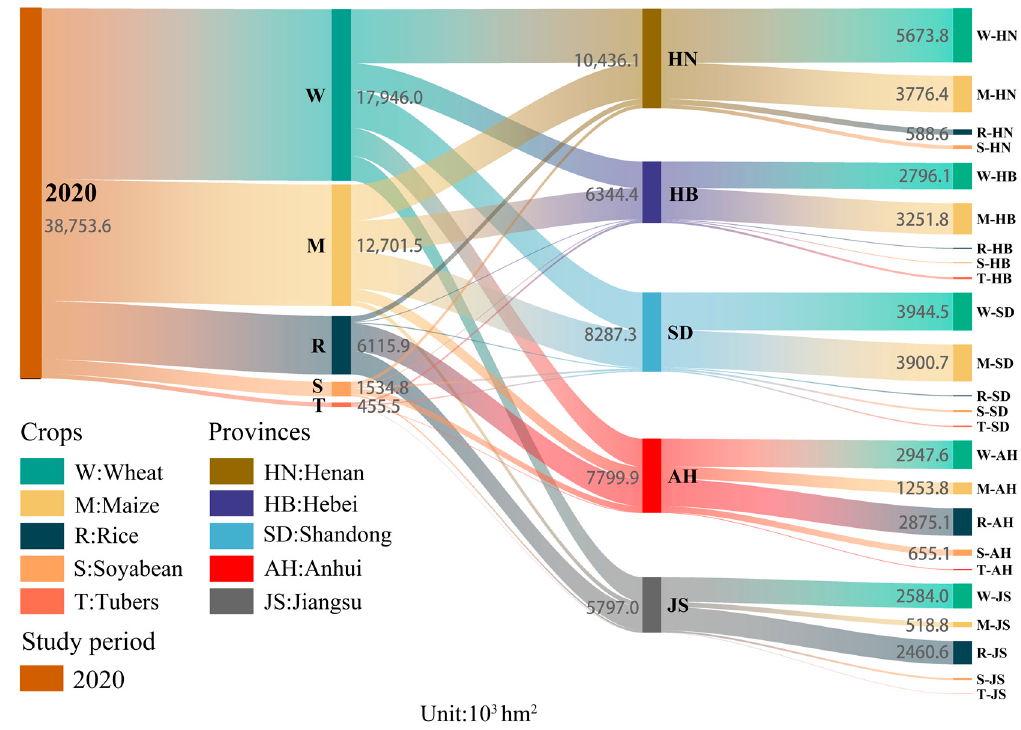
Figure 3. The structure of food crops in 2020 in the main grain-producing area of North China.